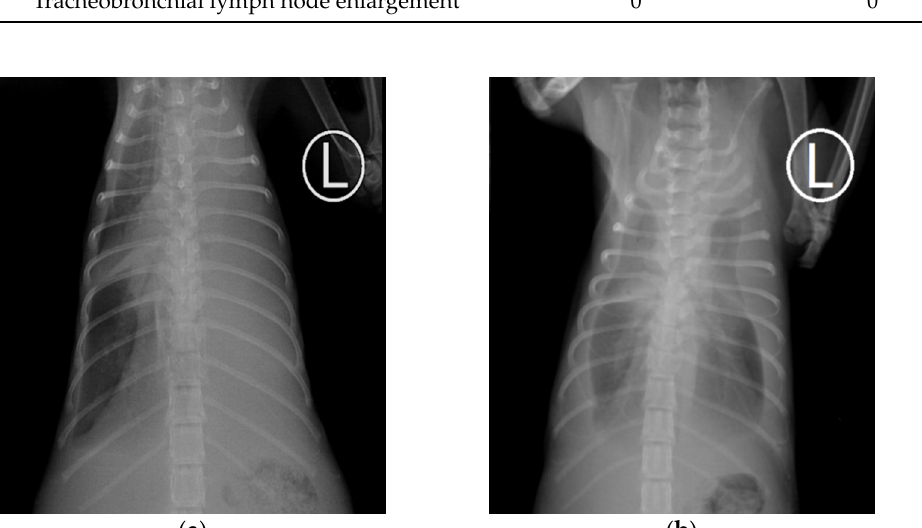
Figure 1. Ventrodorsal radiographs of feline pyothorax: ( a ) Unilateral pleural effusion; ( b ) Bilateral pleural